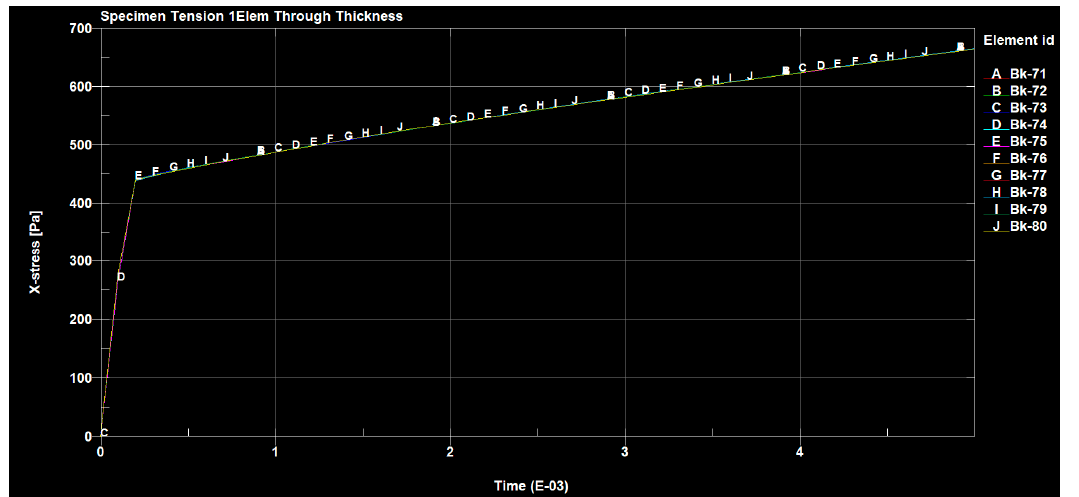
Figure 27. Sample deformation in the 𝑥 direction.